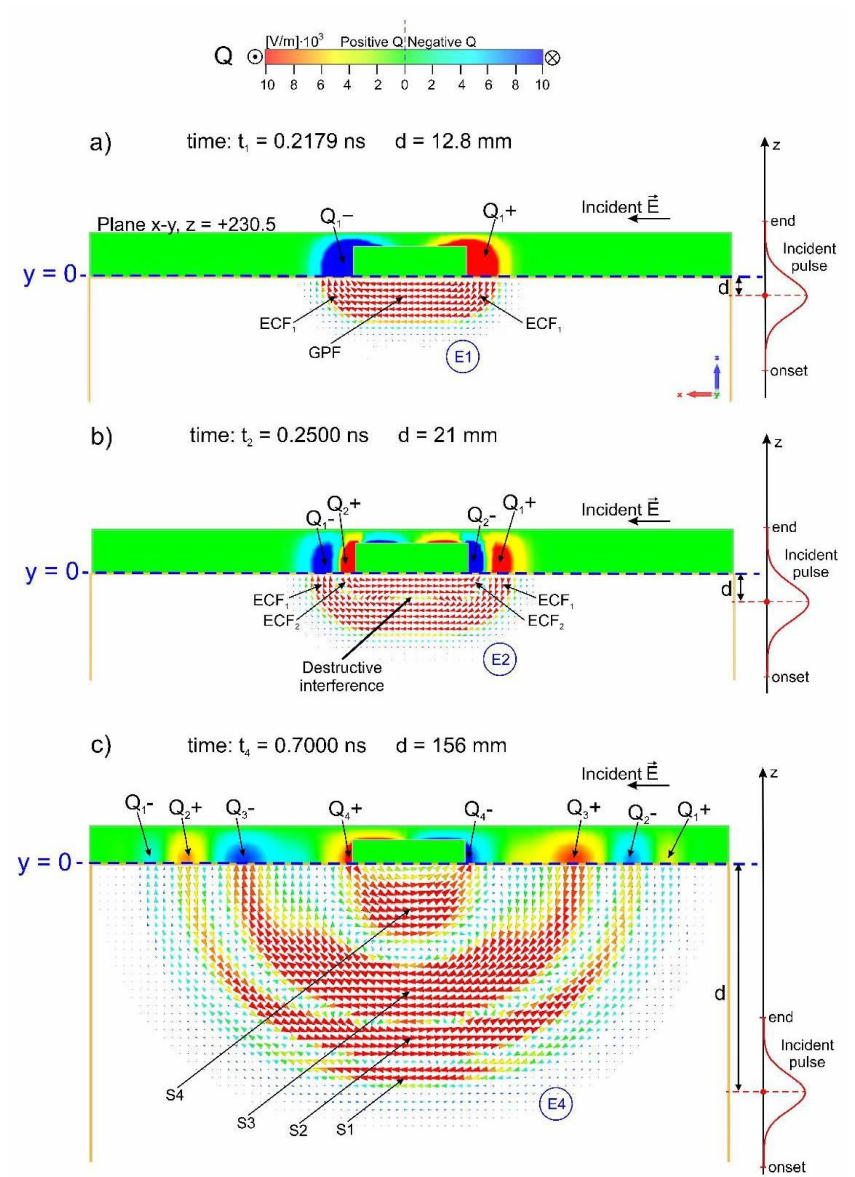
Figure 4. 2D development of the electric charge Q (positive Q i +, negative Q i − , i = 1, 2, 3, 4) on the inner side of the front wall plane of the enclosure (z = +230.5 mm) and electric field strength the x–z plane (y = 0) in the part of enclosure. E1, E2, E4—the electric field interference structures at times: 0.2179 ns, 0.2500 ns, and 0.7000 ns, respectively. The pair of electric charges (Q i +, Q i − ) forms an electric dipol-like arrangement. d—the distance between the incident pulse maximum (marked in red dot) and the inner side of the front wall of the enclosure: ( a ) d = 12.8 mm (the half-maximum of the rear part of the incident pulse passes the front wall inner plane of the enclosure), ( b ) d = 21 mm (the one-tenth of the rear part of the incident pulse passes the front wall inner plane), ( c ) d = 156 mm (the incident pulse fully passed the enclosure front wall plane). The bold arrow in ( b ) shows the place in the E2 structure where the destructive interference occurred. S1, S2, S3, S4—the electric field interference substructures of the structure